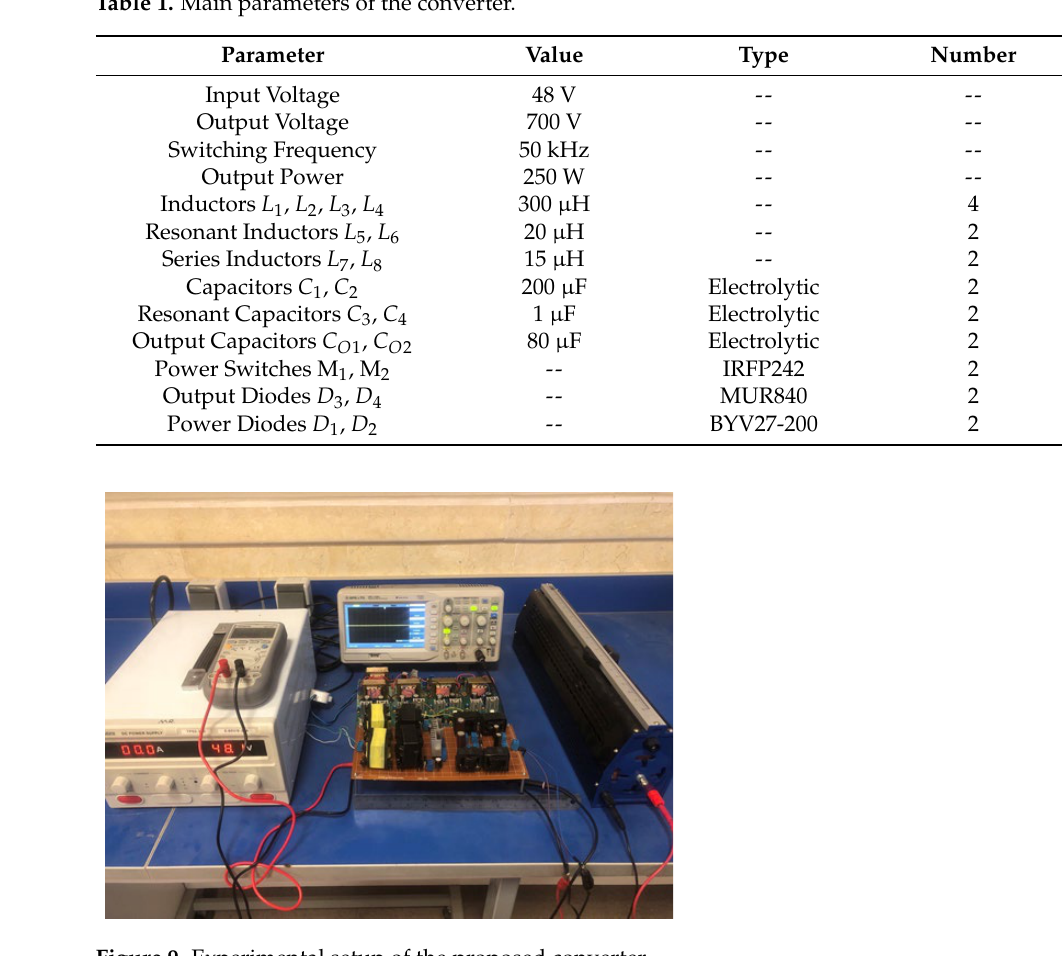
Figure 9. Experimental setup of the proposed converter.